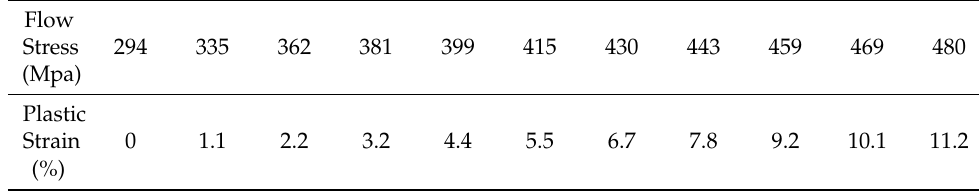
Table 1. Isotropic hardening data for Aluminium